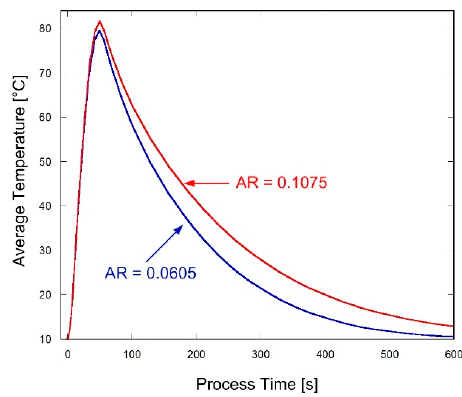
Figure 4. The average temperature of the metal hydride for the aspect ratio of 0.0605 and 0.1075.